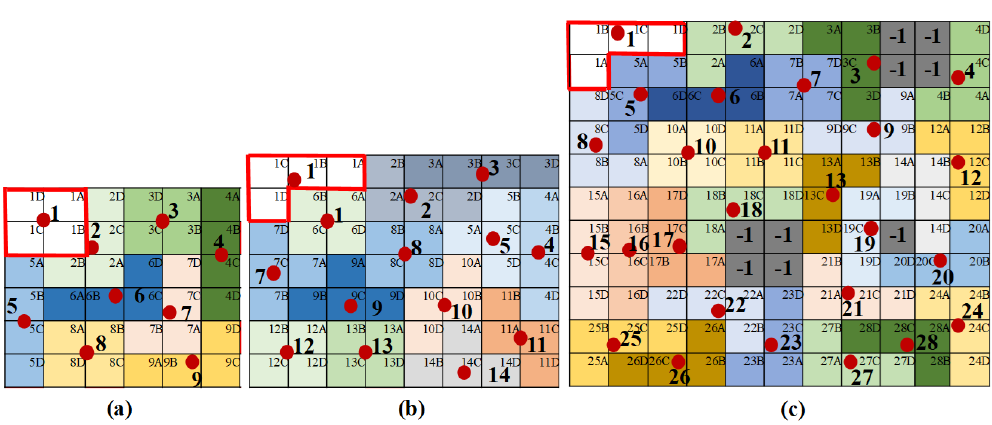
Figure 12. Tilesets with accociated COM for grid-based workspaces. ( a ) workspace of 6 × 6, ( b ) workspace of 8 × 7, ( c ) workspace of 11 × 11 with obstacles.